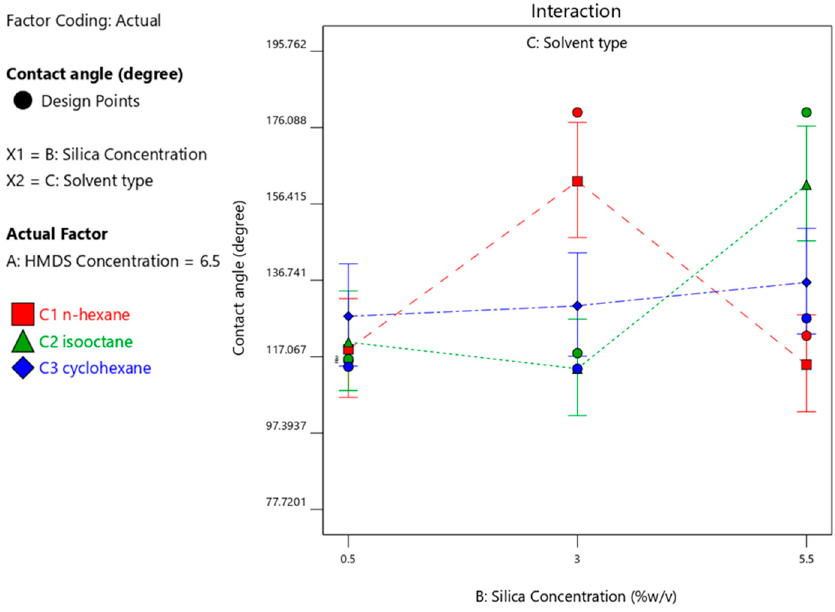
Figure 9. Contact angle response upon interaction between silica concentration and solvent type with 6.5%- v / v HMDS.